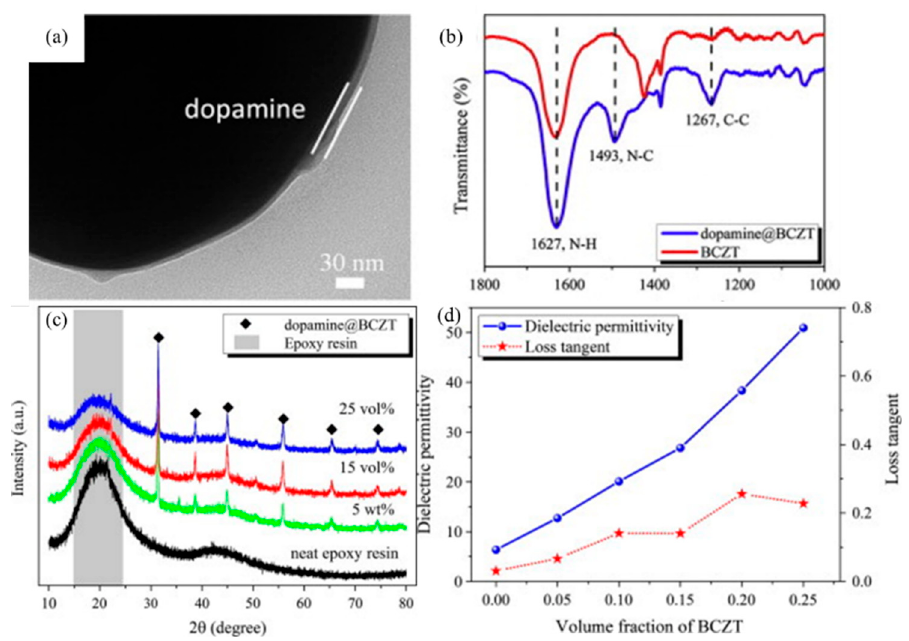
Figure 6. ( a ) The TEM image of dopamine@BCZT powders, the coating layer is about 15 nm; ( b ) FTIR spectra of ceramic powders before and after dopamine modification. ( c ) The XRD patterns of ceramic/epoxy resin composites with different volume fractions of dopamine@BCZT powders. ( d ) The dielectric constant and dielectric loss tangent of dopamine@BCZT/epoxy resin composites with various concentrations of dopamine@BCZT powders at 1000 Hz and room temperature [100].